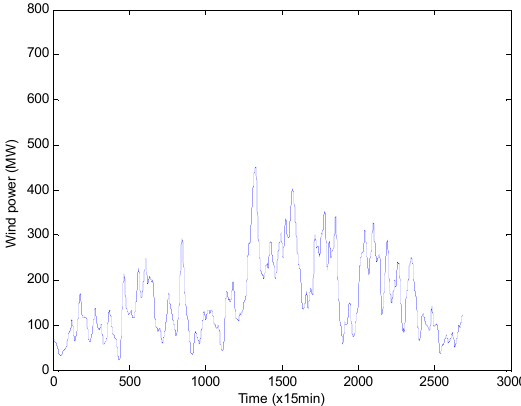
Figure 1. Wind power output curve for one month.